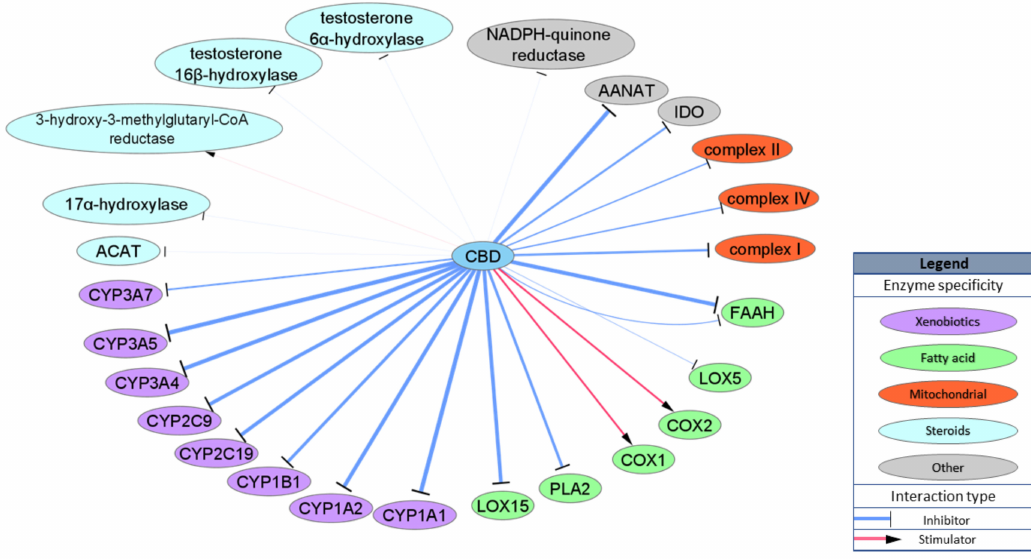
Figure 4. Schematic representation of CBD enzyme targets. Width of the edges (lines) represents relative EC / IC50 ranging between 77 and 30,000